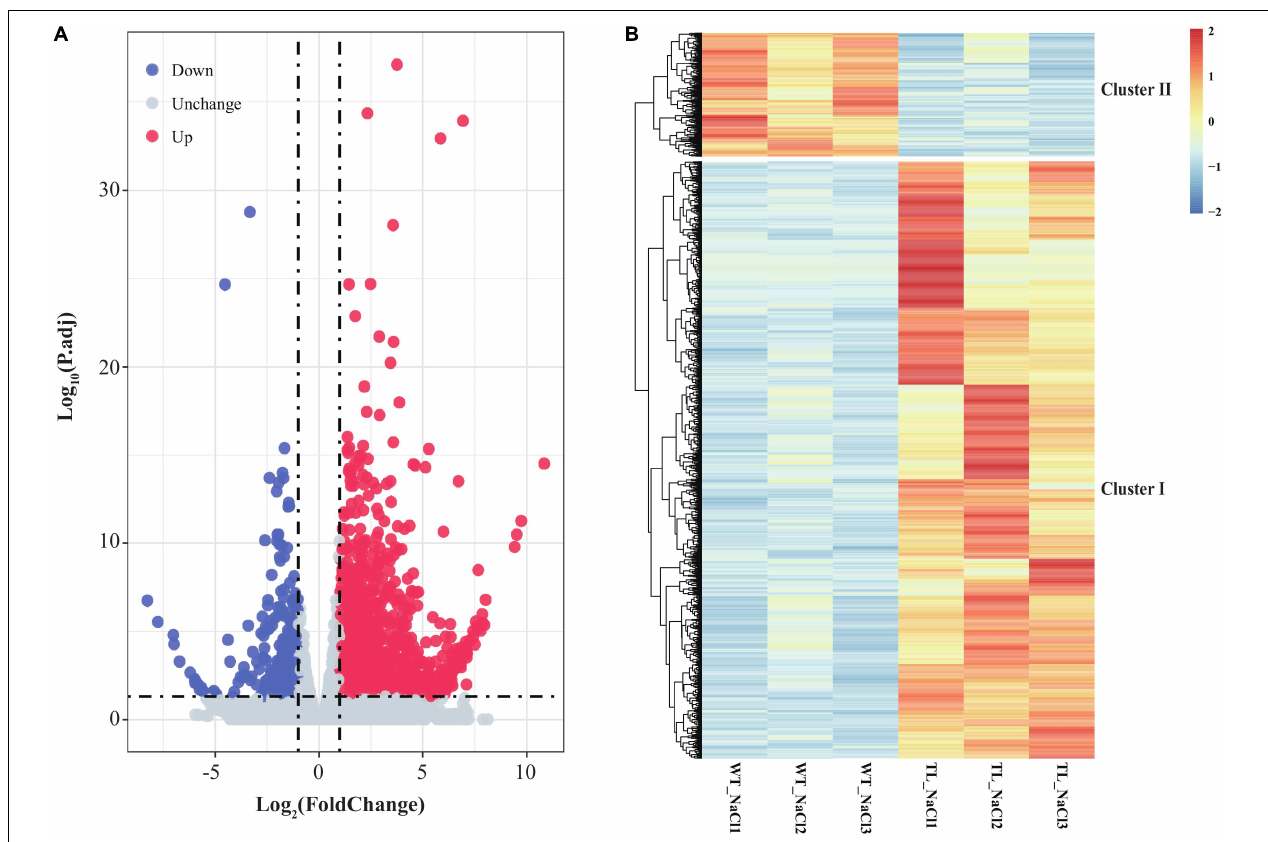
FIGURE 5 | Volcano plot and expression patterns of differential transcripts in leaf sheaths of EsMYB90 transgenic tobacco relative to wild type. (A) Volcano plot exhibiting the differential expression level of transcripts detected in the RNA-seq. The abscissa represents the logarithm of fold change (TL/WT) of transcripts (log2FC) under 200 mM NaCl; the ordinate indicates the –log 10 (p.adj). Red dots represent the upregulated differential transcripts; Blue dots represent the downregulated differential transcripts; Light gray dots represent the transcripts that were detected with no significant difference. (B) The heat map displays the distinguished expression patterns of the differential expressed genes (DEGs). The transcript’s abundance calculated as FPKM is shown in the color legend, where red indicates the transcripts with a higher level, and blue indicates transcripts with a lower level.